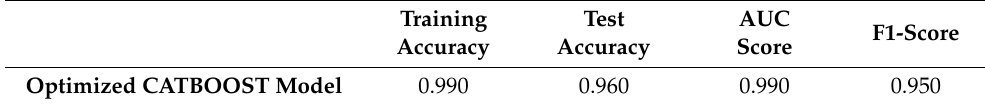
Table 4. Optimized CATBOOST model’s performance on all the evaluation